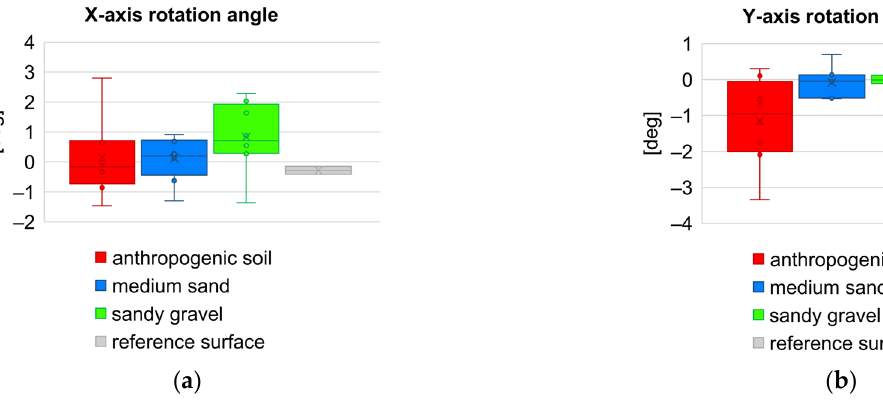
Figure 16. Box plot comparison of inclination angles of the wall surface: ( a ) deviation from verticality; ( b ) deviations from straightness (along the diaphragm wall).